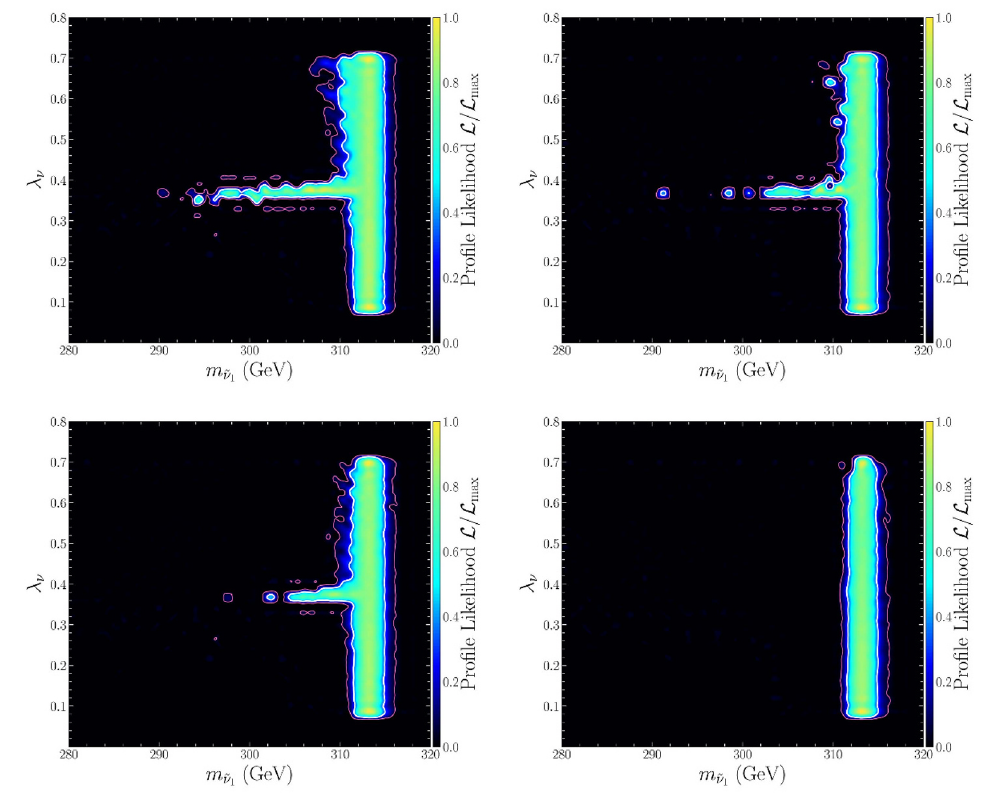
Figure 6 . Same as figure 1, but for the massive h s scenario defined in table